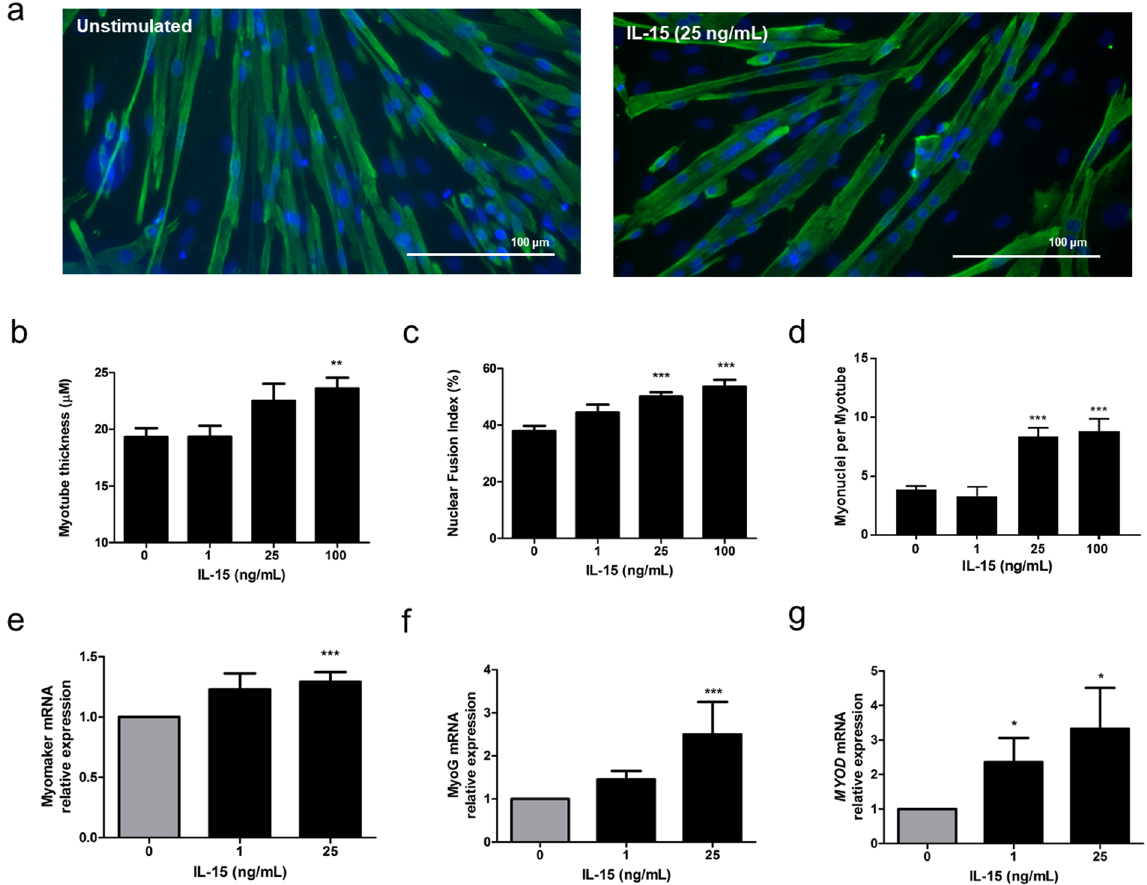
Figure 1. Recombinant IL-15 stimulation of differentiating primary human myoblasts enhances myotube formation and promotes myogenic gene expression. Subconfluent myoblasts were switched to differentiation medium containing the indicated concentrations of IL-15 for 8 d. Media were renewed every 2 d. Myotubes were fixed, immunofluorescence stained for desmin and with DAPI and imaged on an epifluorescence microscope. ( a ) Representative images at 20x magnification. ( b ) Myotube thickness data represents the mean ± SEM of 450 total measurements taken at 63x magnification from 90 myotubes per treatment condition (n = 3 biological replicates). ** p < 0.01 vs. unstimulated (0 ng/mL) condition by Mann-Whitney U test with post-hoc Holm’s sequential Bonferroni adjustment. ( c ) Nuclear fusion index data is expressed as mean ± SEM values from 45 images taken at 20x magnification from 3 biological replicates. *** p < 0.001 vs. unstimulated (0 ng/mL) condition by one-way ANOVA with post-hoc Bonferroni correction. ( d ) Number of myonuclei per myotube is expressed as mean ± SEM values from 15 images taken at 20x magnification from 3 biological replicates. ( e ) Primary human myoblasts were stimulated with recombinant IL-15 at the indicated concentrations for 8 days. Media were renewed every 2 d. *** p < 0.001 vs.unstimulated condition by one-way ANOVA with post-hoc Bonferroni correction. ( f , g ) Subconfluent myoblasts were switched to differentiation medium containing the indicated concentrations of IL-15 for 8 d. Media were renewed every 2 d * p < 0.05, *** p < 0.001 vs. unstimulated condition by Mann-Whitney U test with post-hoc Holm’s sequential Bonferroni adjustment. Data expressed as mean ± SEM. 3 technical replicates (each assayed in triplicate) per biological replicate, 3 biological